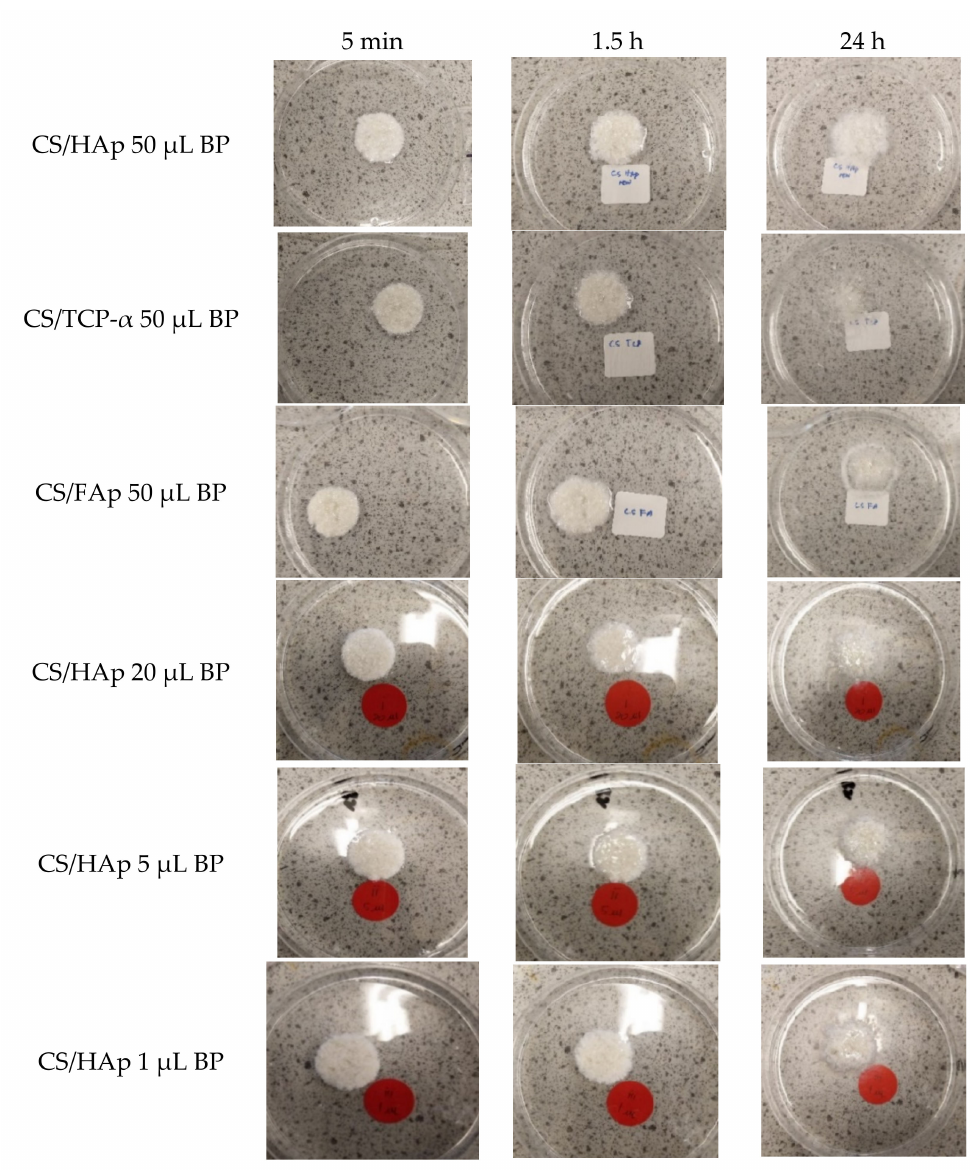
Figure 2. Photographs of CS scaffolds with various ceramics and BP content which were placed in 1% v/v acetic acid solution in the water acting as a solvent for CS. Minimal swelling or dissolution was observed for up to 24 h indicating the success of the crosslinking